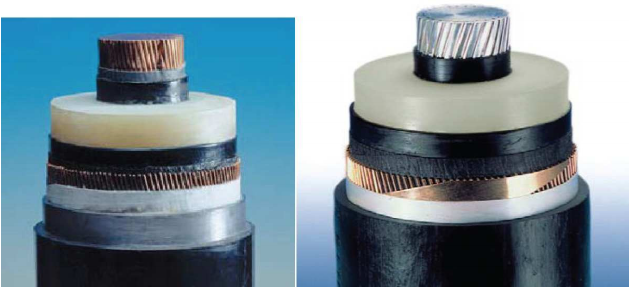
Fig. 1. Typical high-voltage (110 kV)